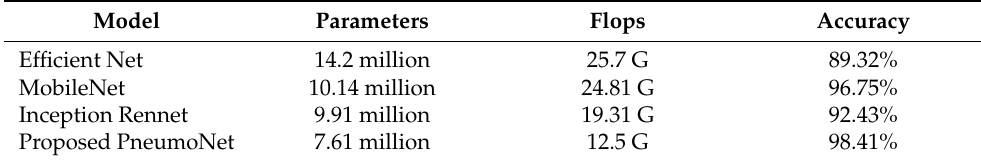
Table 5. Computational complexities of the proposed approach.